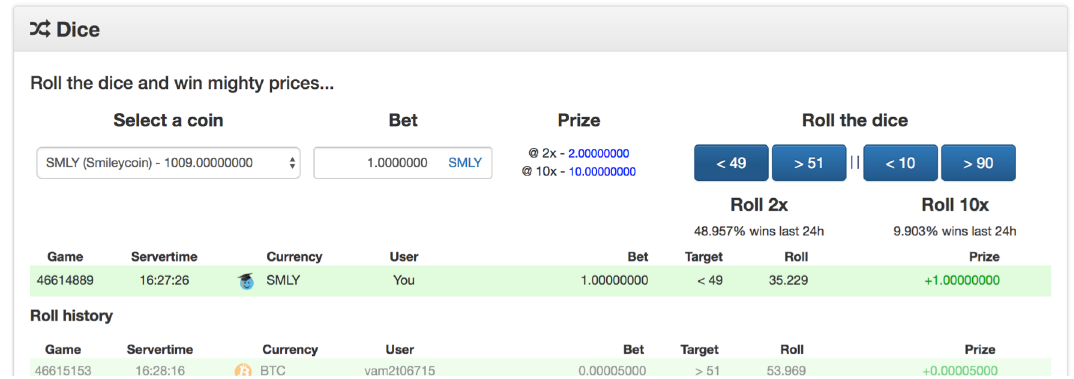
Fig. 5. Dice games at